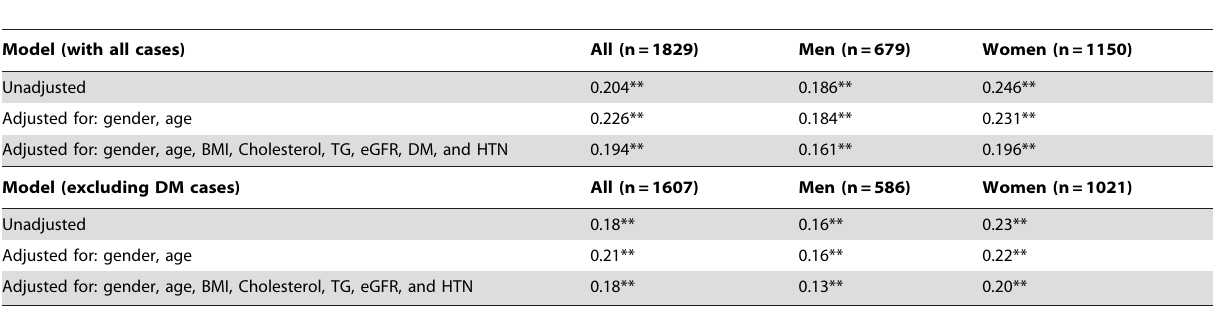
Table 3. Standardized coefficient ( b ) for linear regression of ln(ACR) as a function of uric acid (independent variable).